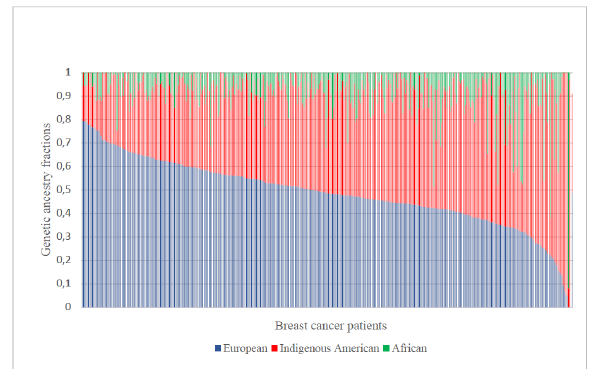
FIGURE 1 Genetic ancestry distribution for 381 breast cancer patients from Columbia. Each patient is represented by a vertical bar at the